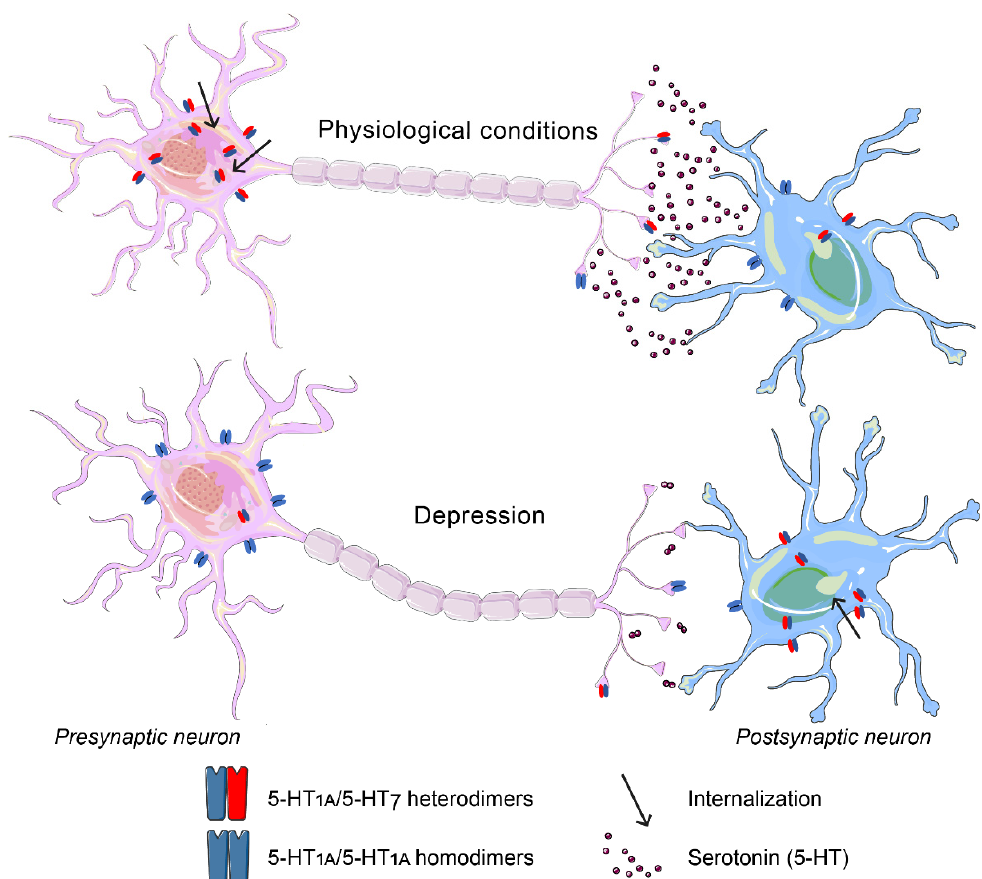
Figure 3. Hypothetical mechanism of the role of 5-HT 1A /5-HT 7 receptor heterodimerization in the mechanism of depression. Under physiological conditions, the amount of 5-HT 1A /5-HT 7 heterodimers in presynaptic neurons is higher than in postsynaptic neurons; under depression, the 5-HT 1A /5-HT 1A homo- and 5-HT 1A /5-HT 7 heterodimers ratio in presynaptic neurons shifts towards 5-HT 1A /5-HT 1A homodimers which decreases the amount of 5-HT in the synaptic cleft.